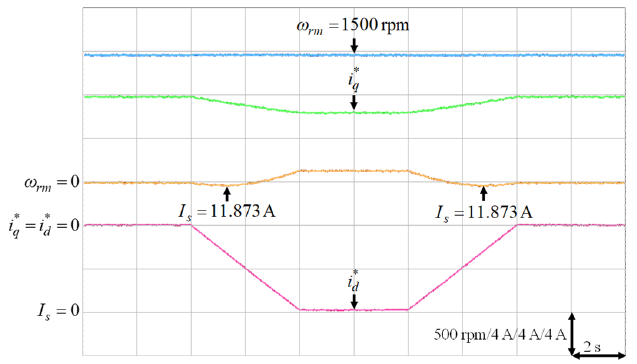
Figure 19. Experimental results of finding the lowest stator current at 1500 rpm with 9 Nm.